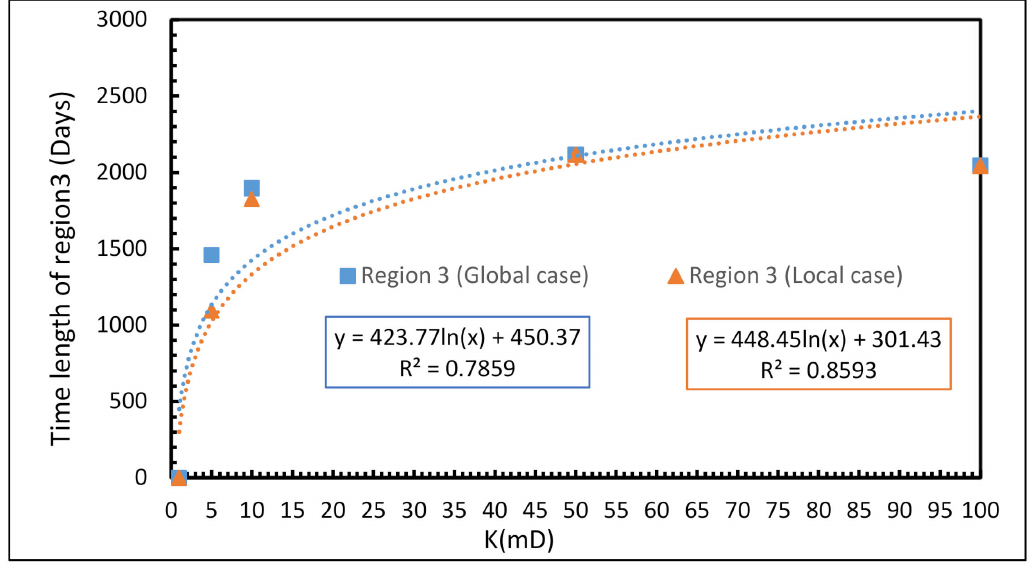
Figure 8. Duration of Region 3 as a function of permeability at the wellbore for both